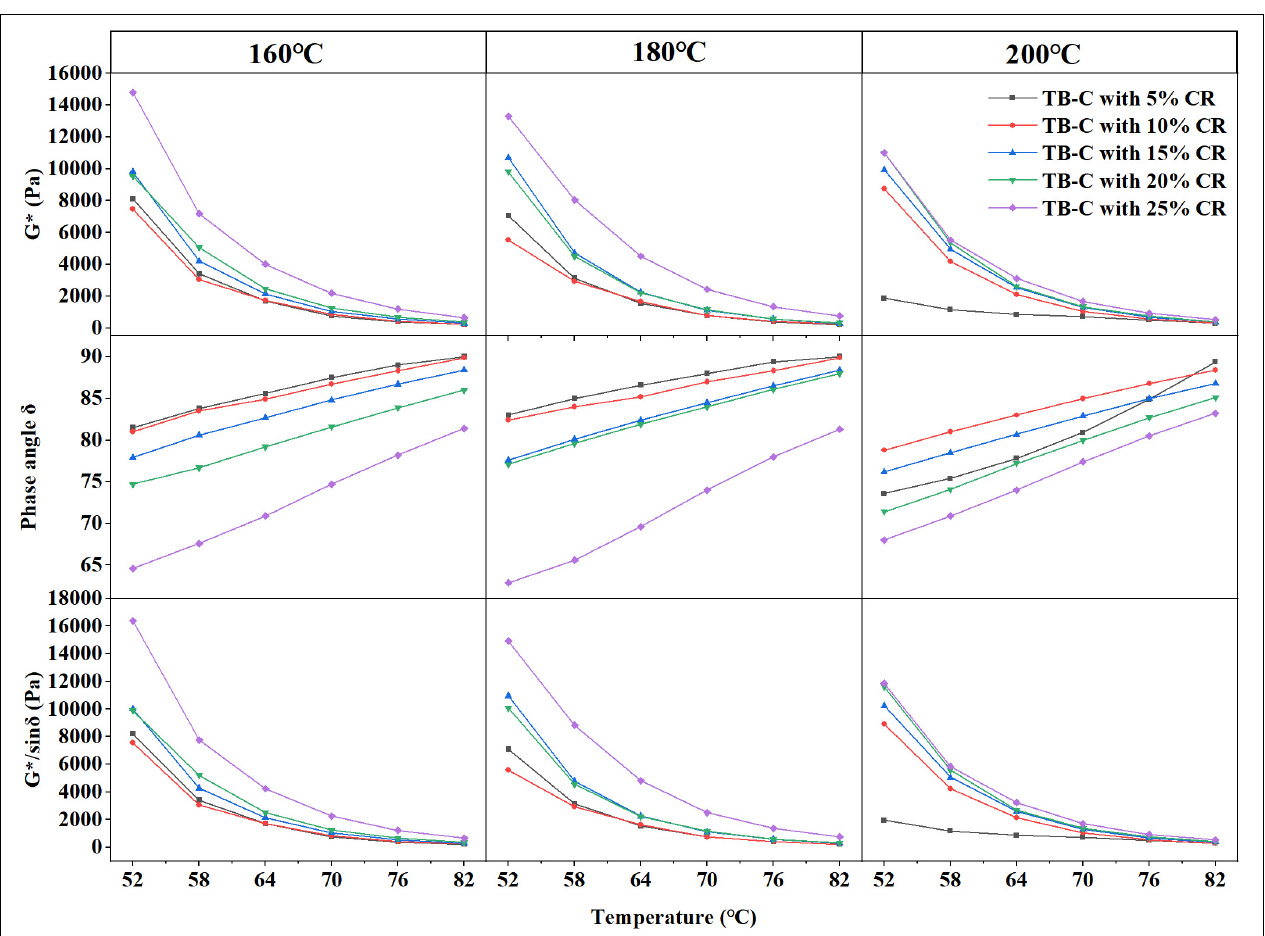
FIGURE 5 | G*, δ and G*/sin δ of